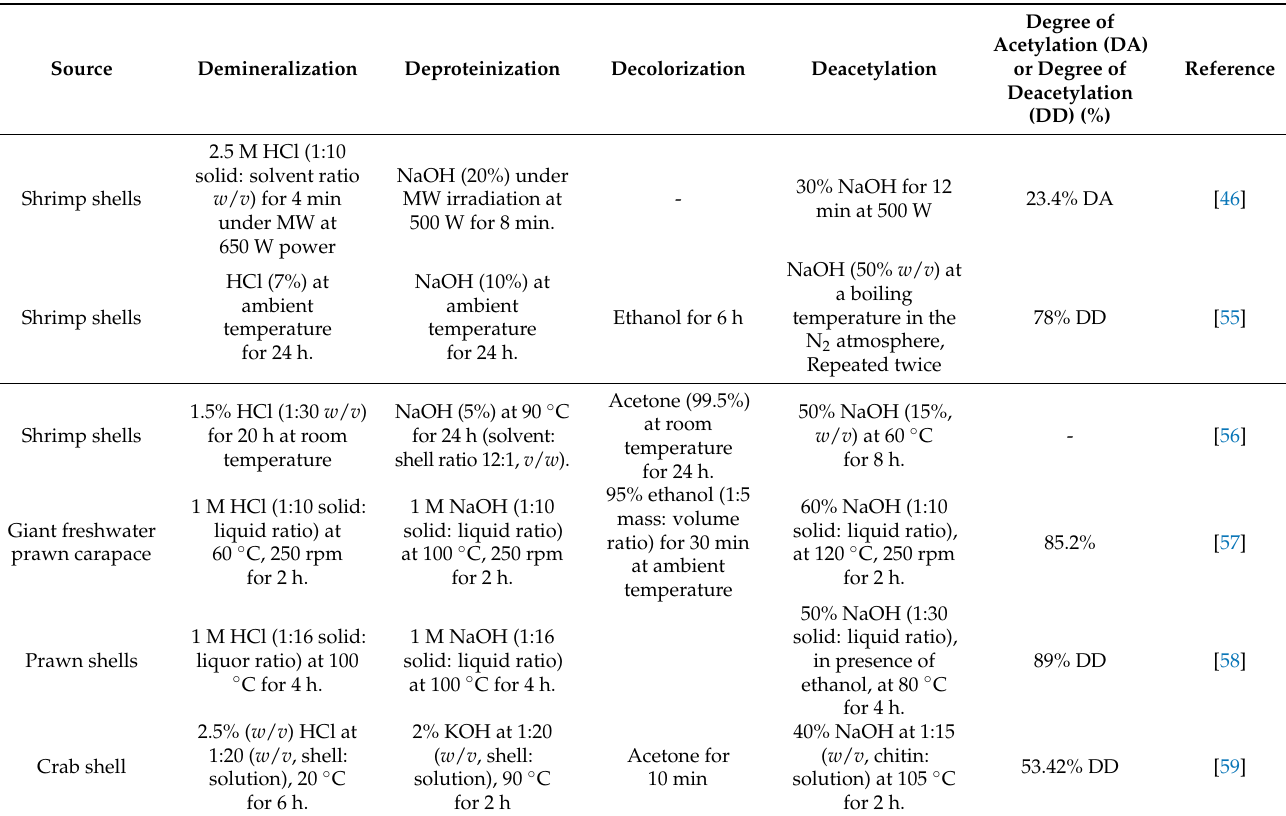
Table 2. Deacetylation conditions in CS